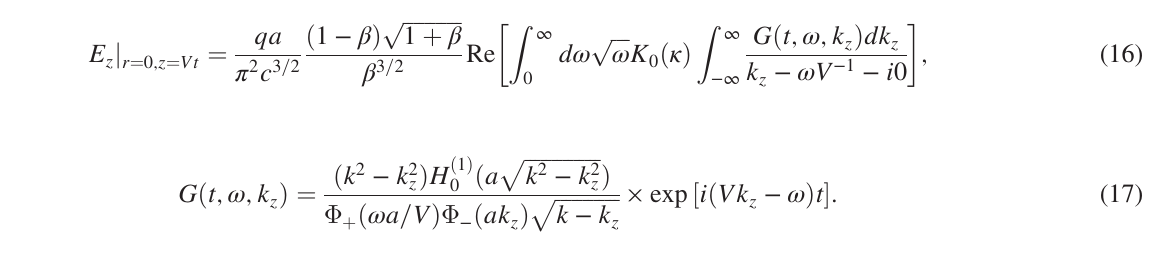
ffiffiffiffiffiffiffiffiffiffiffiffiffiffi k 2 − k 2